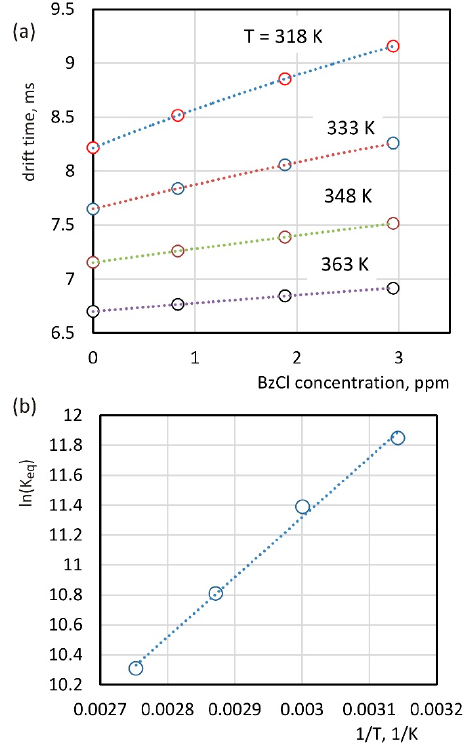
Figure 7. Peaks positions measured for the introduction of BzCl to the drift gas ( a ) and a plot of the logarithm of the equilibrium constant versus the reciprocal of temperature ( b ). Table 3. Equilibrium constants for Equation (2) calculated from the peak shift in the drift time spectra for different BzCl concentrations in the drift gas.